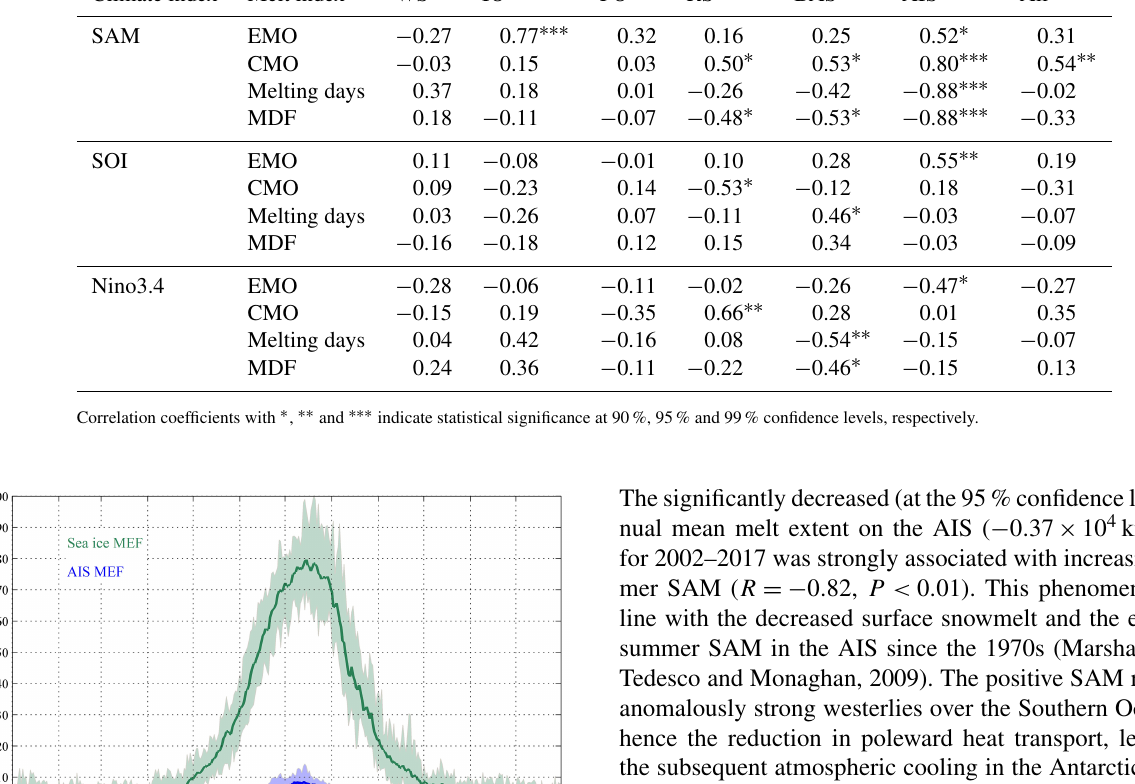
Table 2. Correlation between snowmelt index and climate index for the period 2002–2017. Climate index